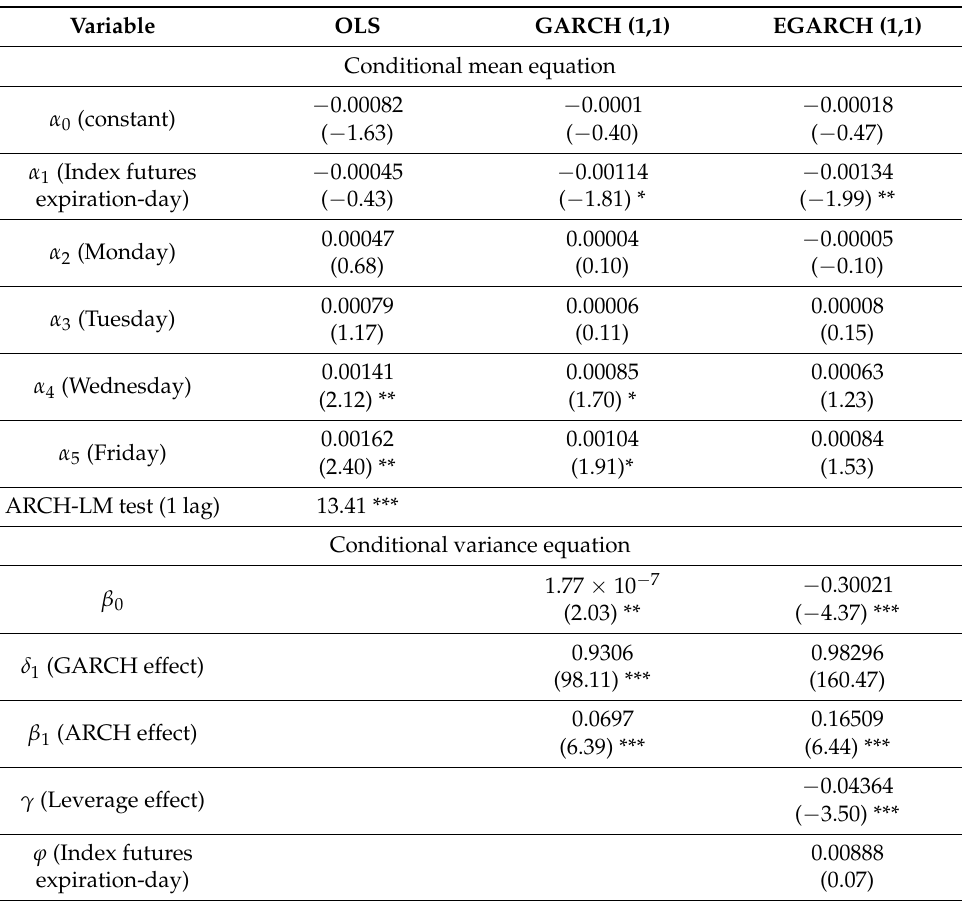
Table 3. The effects of index futures expiration-day on market returns and